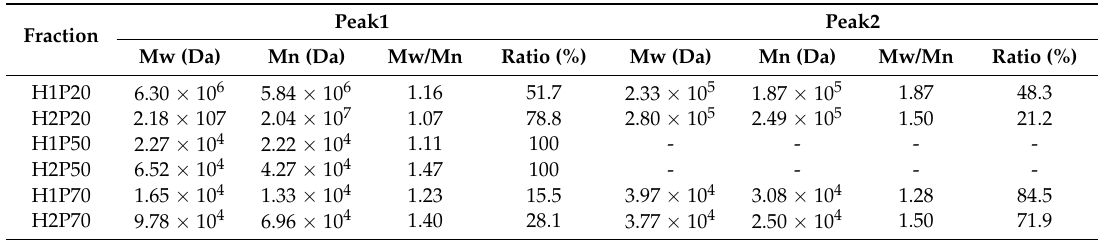
Table 2. Molecular weight distribution of 20%, 50%, and 70% ethanol precipitated polysaccharides